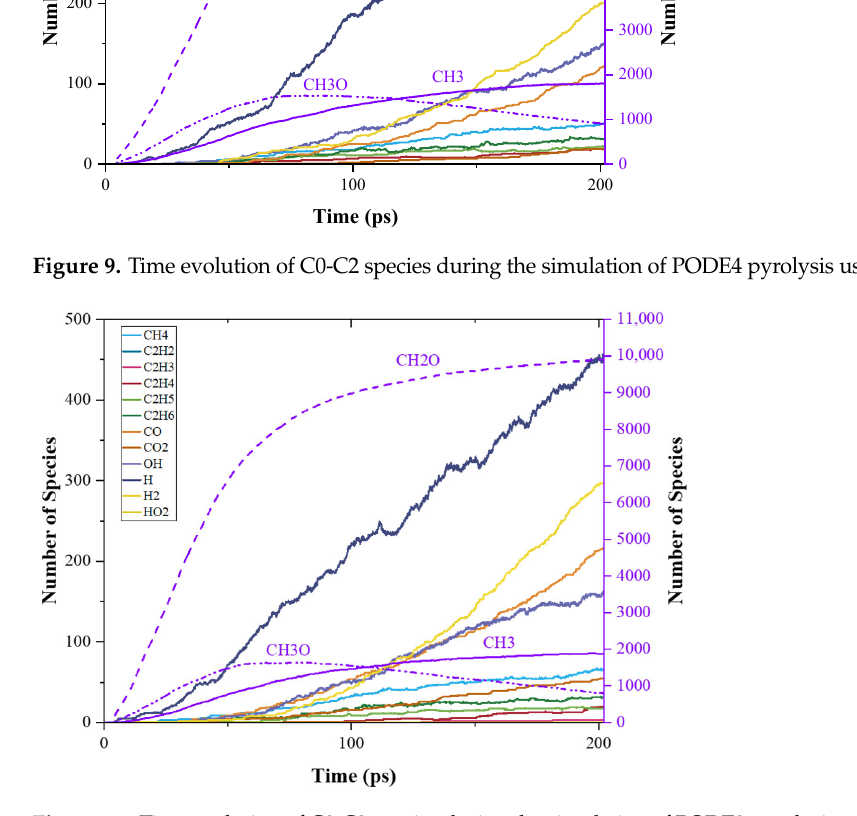
Figure 10. Time evolution of C0 ‐ C2 species during the simulation of PODE3 pyrolysis using ReaxFF MD.